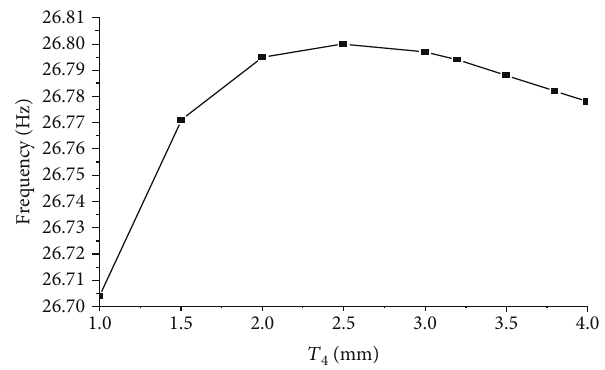
Figure 18: In fl uence of inertial bracket beam thickness on the fi rst modal frequency of equipment bay.